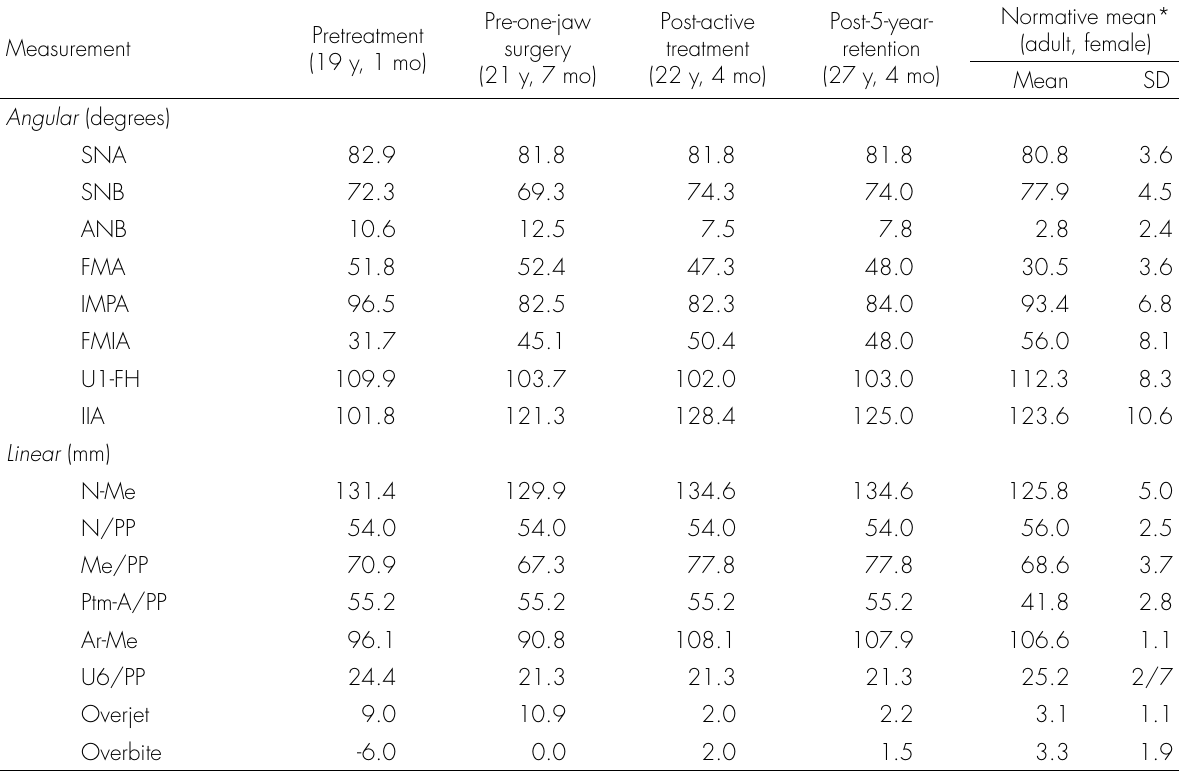
Table I. Cephalometric analysis at pretreatment, pre-one-jaw-surgery, post-active treatment, and post-retention stages.